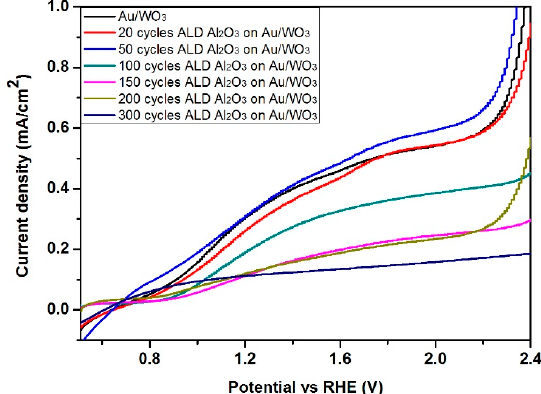
Figure 9. XPS spectra of ( a ) Al 2p and ( b ) Au 4f in Al 2 O 3 /Au/WO 3 nanostructures with various cycles of ALD Al 2 O 3 thin film.